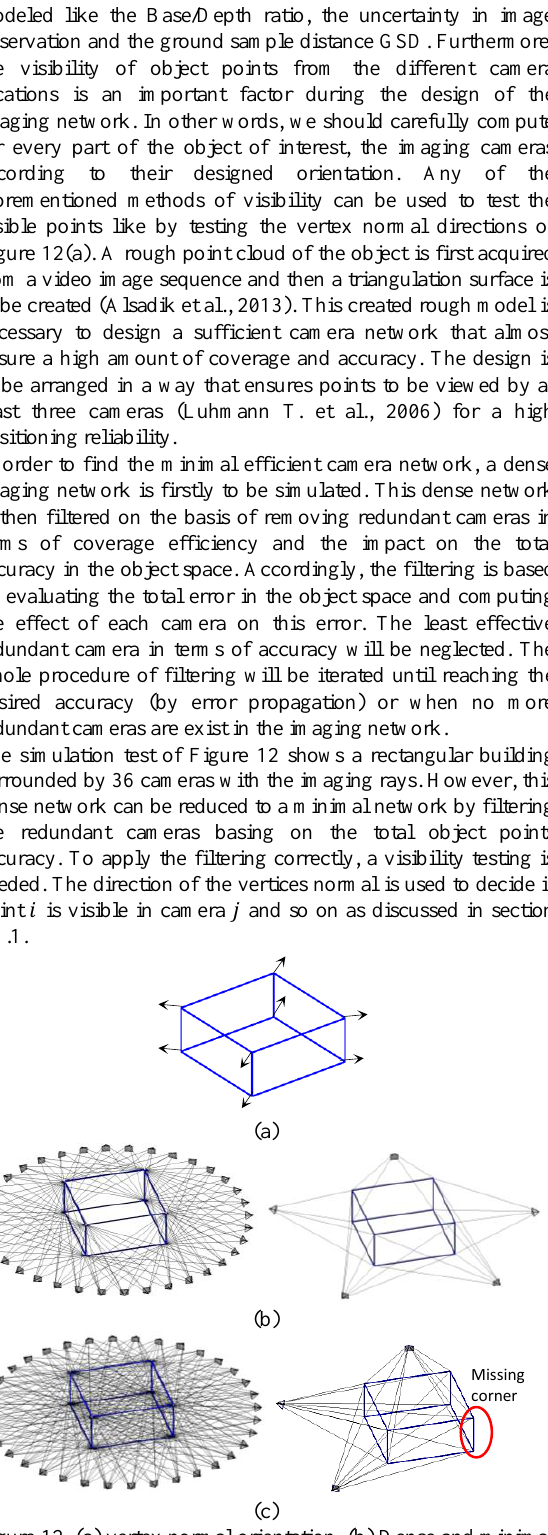
Figure 12. (a) vertex normal orientation. (b) Dense and minimal camera network with visibility test. (c) Dense and minimal network without visibility test.